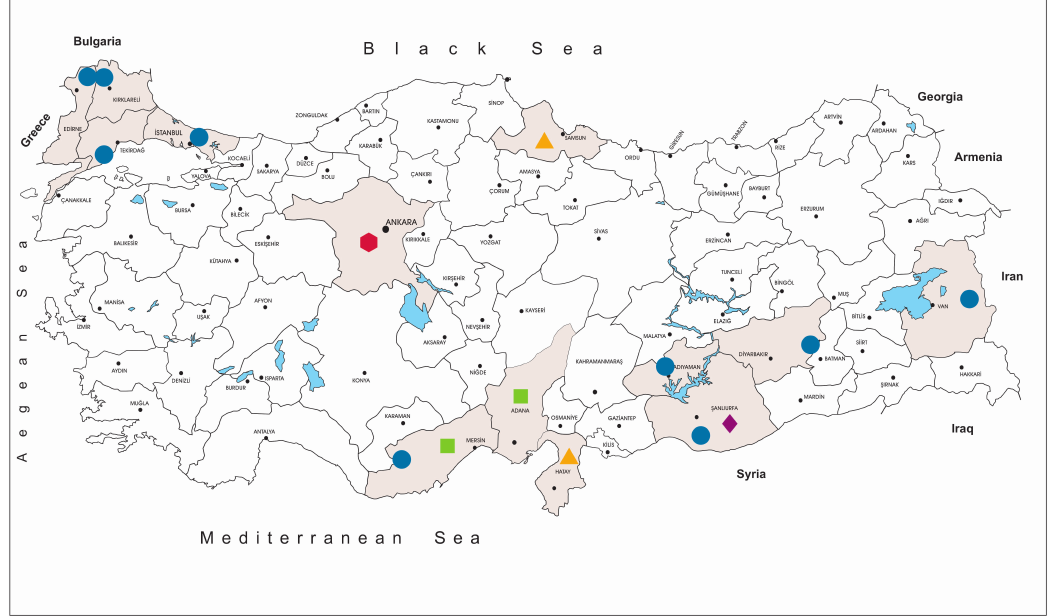
Figure 1. Retinal ganglion cell loss in injured and contralateral retinas: influence of the lesion distance. Figure 1. Illustrative map of the locations used for specimen collection in the study (circle: tick, triangle: Scatter graphs showing the percent versus intact (100%, dotted line in ( A ); I in ( B )) of surviving retinal avian, square: canine, diamond: bovine, hexagon: ganglion cells (RGCs). Black lines indicate the mean percent standard deviation. ( A ) In the injured ± retinas and in both experimental paradigms, RGC death was first significant at day 3, progressed steeply up to 14 days, and slowly thereafter. There were no significant di ff erences between optic nerve crush (ONC) 0.5 mm and ONC 2 mm at any time point. ( B ) In the contralateral retinas, there was a significant decrease of RGCs at day 9 in the ONC 2 mm group, which did not progress further. In the ONC 0.5 mm group, RGC loss reached statistical significance at 45 days, and it also did not progress at 90 days.